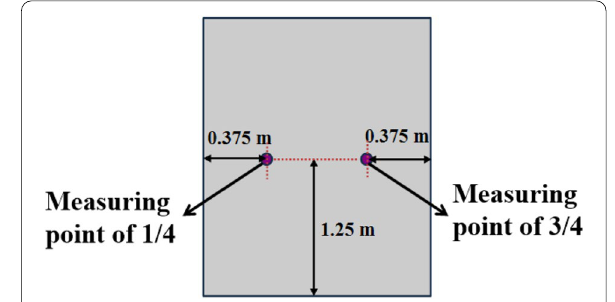
Fig. 4 Location of acceleration sensors installed on each outer surface of